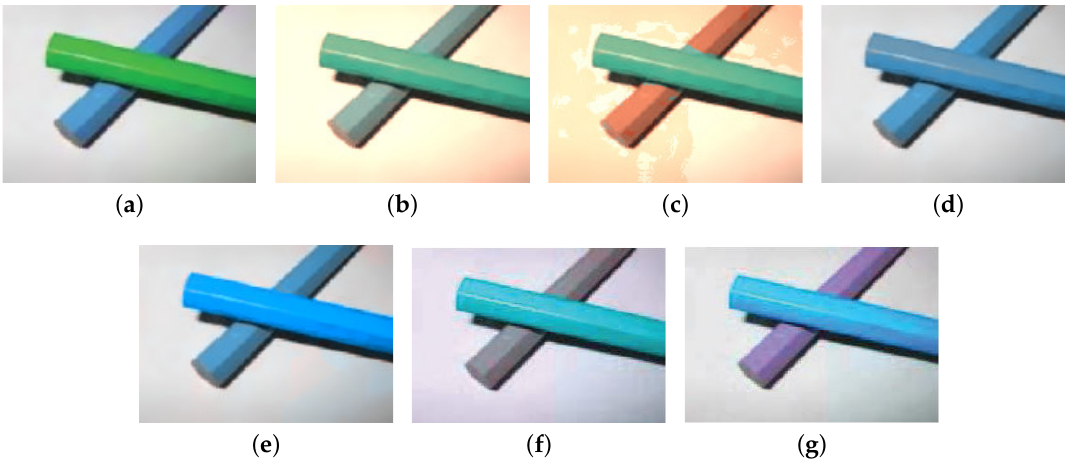
Figure 13. The comparison of tritanopia simulation of the pencil image. ( a ) The original image. ( b ) The CVD simulation using Machado’s method. ( c ) Machado’s CVD simulation on the image processed by the proposed re-coloring technique. ( d ) The CVD simulation using Brettel’s method. ( e ) Brettel’s CVD simulation on the image processed by the Kuhn’s re-coloring technique. ( f , g ) CVD simulation and re-coloring using Huang’s approach.